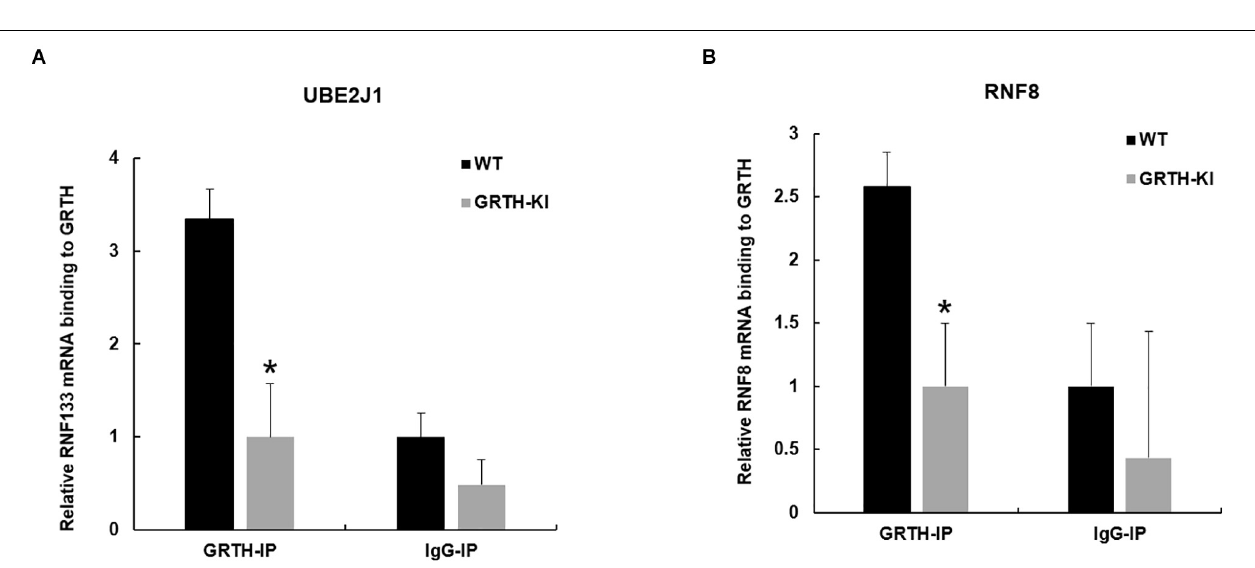
FIGURE 5 | Binding of GRTH protein to Ube2j1 and Rnf8 mRNA in KI vs WT mice. Relative mRNA binding of Ube2J1 (A) , and Rnf8 (B) to GRTH protein in WT and KI mice. Statistical analysis was done using two-tailed Students t -test (*indicates P < 0.05) and data represents mean ± SEM of two independent experiments in